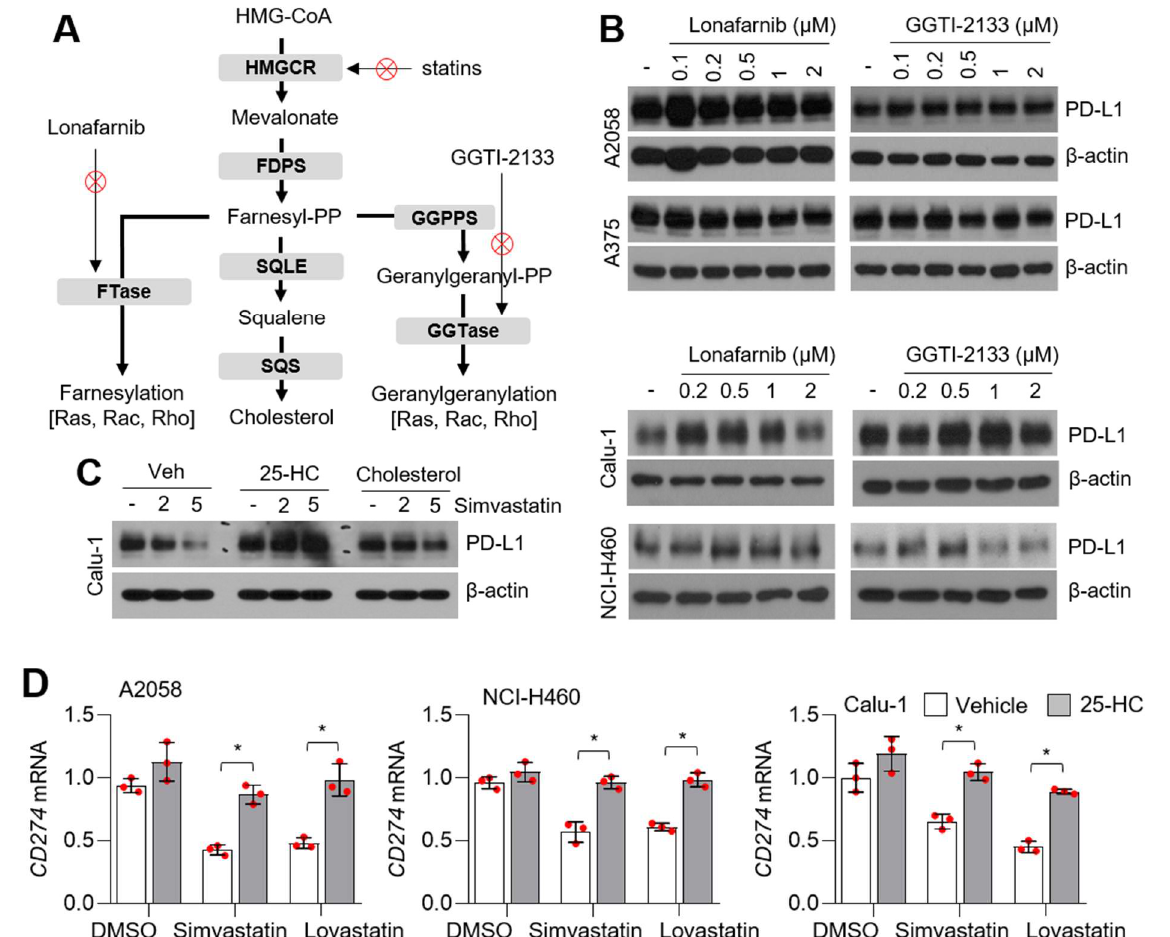
Figure 3. Intracellular cholesterol is associated with the suppression of PD-L1 in statins-treated lung cancer and melanoma cells. ( A ) Schematic representation of the mevalonate and cholesterol biosynthesis pathways. ( B ) Lonafarnib (a selective inhibitor of FTase) and GGTI-2133 (a selective inhibitor of GGTase) did not decrease PD-L1 expression. Lung cancer (Calu-1 and NCI-H460) and melanoma (A375 and A2058) cells were incubated with different concentrations of lonafarnib or GGTI-2133 for 12 h, as indicated. Protein levels were measured by using western blotting. ( C ) Supplement of cholesterol reversed the suppression of PD-L1 by statins. Calu-1 lung cancer cells were pre-incubated with 20 μM of 25-hydroxycholesterol (25-HC) and 0.5 mM of water soluble cholesterol for 6 h, and then cells were further incubated with 2 or 5 μM of simvastatin for 8 h. After drug treatment, protein levels were measured by using western blotting. ( D ) 25-HC reversed the suppression of CD274 by statins treatment. Cells were incubated for 6 h in the absence or presence of 25-HC (20 μM) and then cells were further incubated with 5 μM of simvastatin or lovastatin for 8 h. CD274 mRNA levels were measured by using qRT-PCR. Values represent mean ± SD. Experiments were performed in triplicates. * p < 0.05 by Student’s t -test for two experimental comparisons.